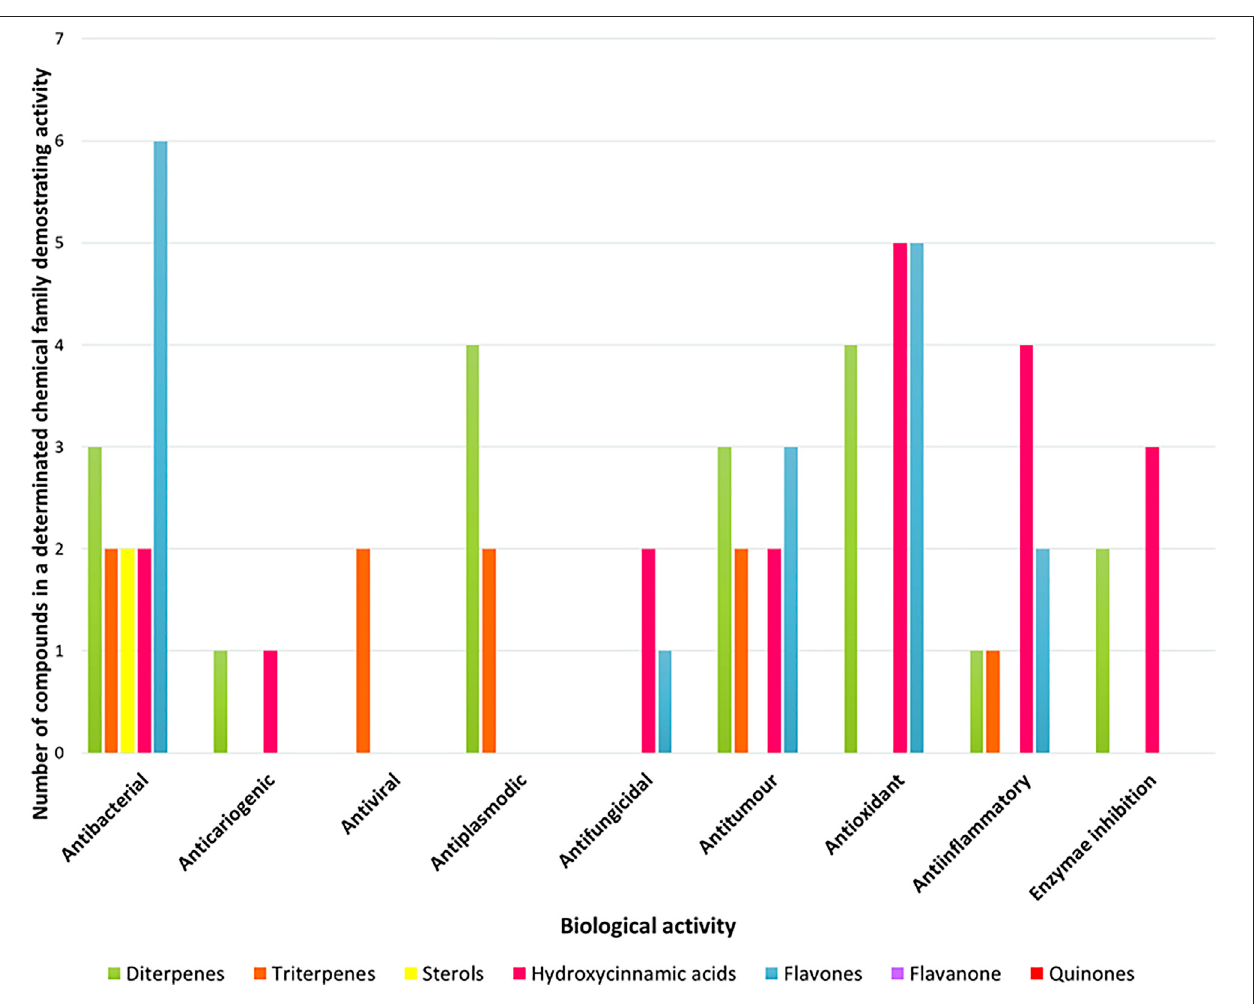
FIGURE 5 | Summary diagram of biological activities demonstrated by each family of